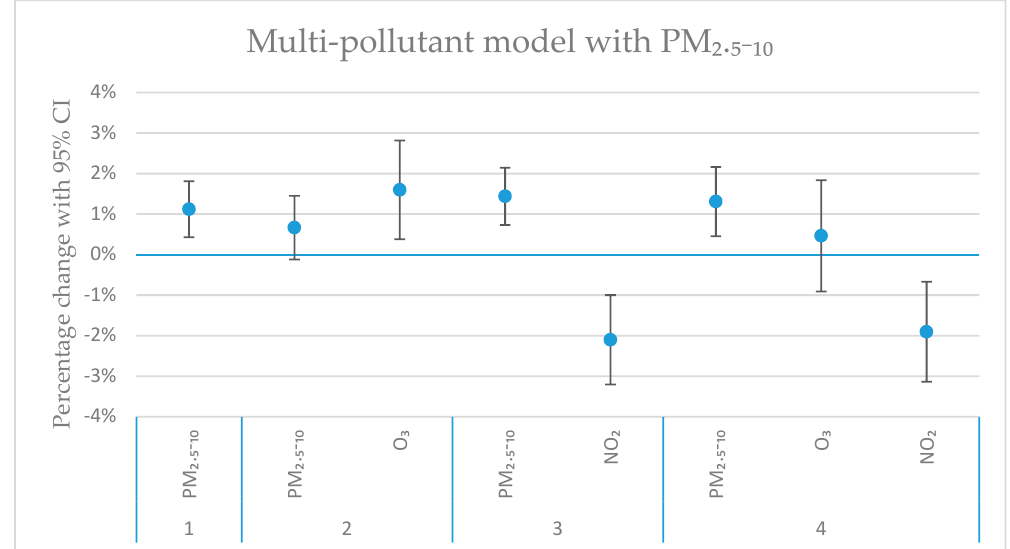
Figure 5. The estimated change in daily mortality (with 95% CI) for an IQR increase in concentration (lag02) to PM 2.5–10 , O 3 and NO 2 in a multi-pollutant model. Model 1 (furthest to the left) represents the single-pollutant estimate of PM 2.5–10 . Model 2 and 3 represent two-pollutant models, with O 3 (Model 2), and with NO 2 (Model 3). In Model 4, both PM 2.5–10 , O 3 and NO 2 are included.